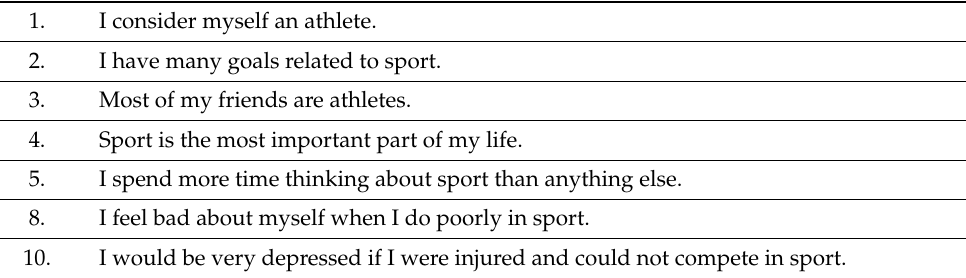
Table A2. Reconceptualized Athlete Identity Measurement Scale Items.